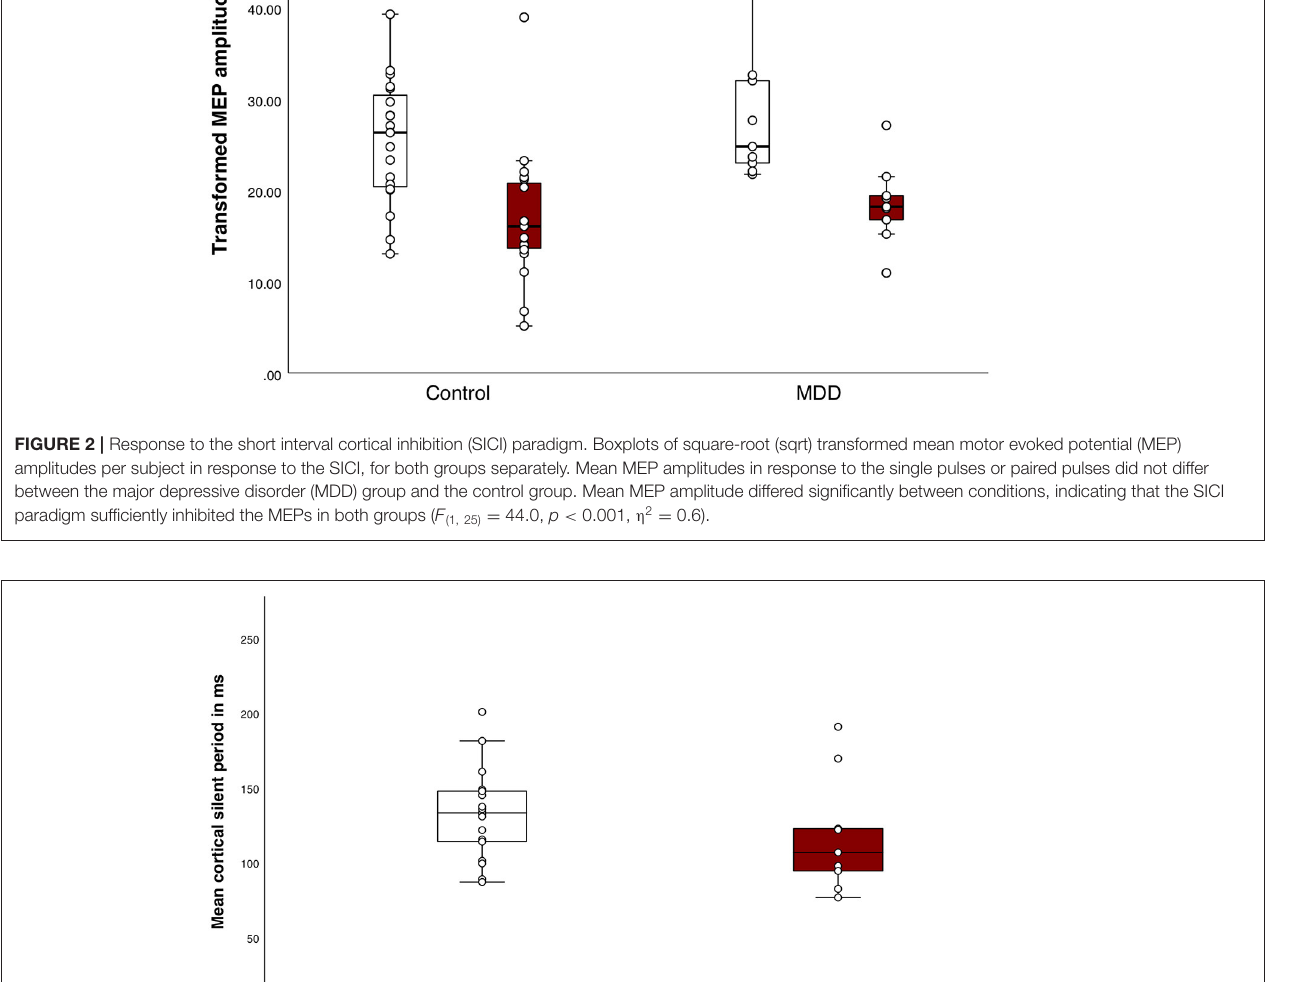
CSP duration between the MDD group and the control group (M c = 132.0 ± 30.0; M MDD = 117.7 ± 38.8) ( t (25) = 1.1, p = 0.3) ( Figure 3